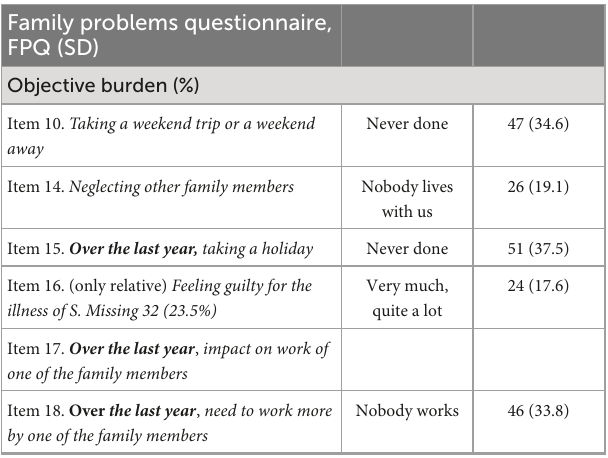
TABLE 4 Selected items relating to objective burden in FPQ. Family problems questionnaire, FPQ